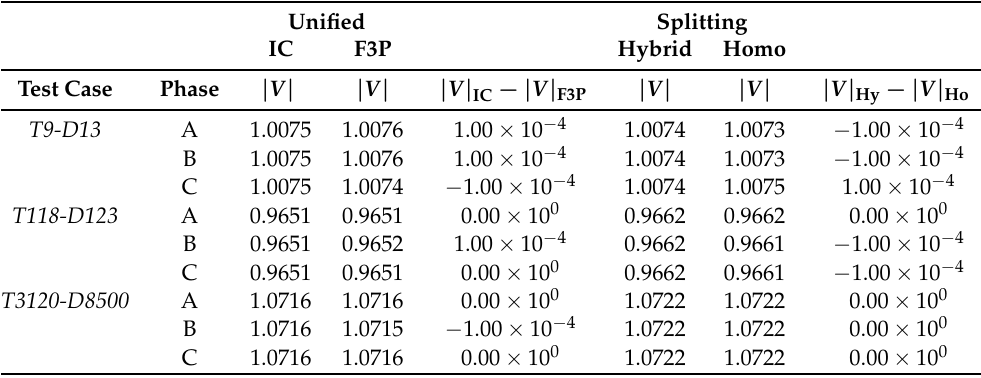
Table 5. Per-unit voltage profiles of the connection bus in different networks and the differences between hybrid and homogeneous network